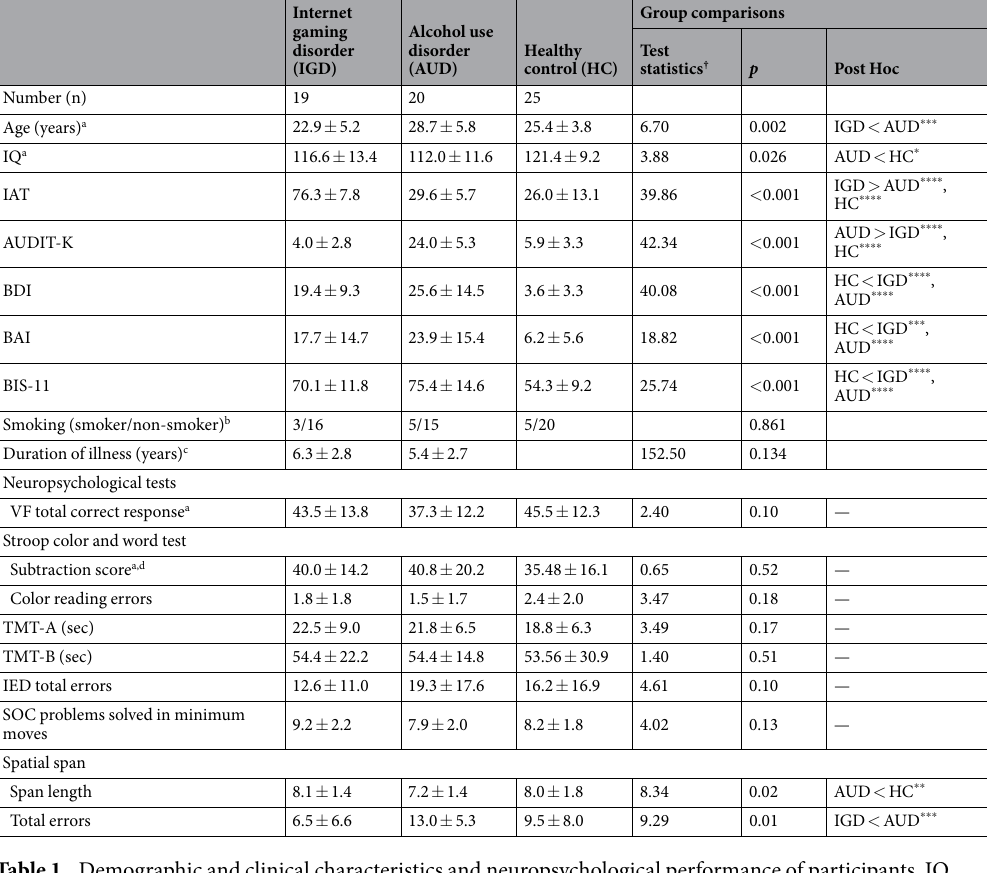
cerebellum compared with controls (minimum cluster size = 973 voxels) (Fig. 1b, Table 2). Comparisons between the IGD and the AUD groups revealed no significant differences in cortical volume. Differences in cortical thickness. the adjacent anterior midcingulate cortex (aMCC) relative to the HCs (peak MNI coordinates, x = − 10, y = 24, z = 37; cluster-wise p = 0.04) (Fig. 2). Relationship between brain cortical changes and clinical characteristics. The gray matter vol- ume in the right hippocampus of the individuals with IGD was positively correlated with their Young’s Internet Addiction Test (IAT) scores ( r = 0.63, p = 0.004) (Fig. 3a). For the AUD group, left cerebellar volume was neg- atively correlated with illness duration ( r = − 0.60, p = 0.006) (Fig. 3b), and bilateral cerebellar volume was negatively correlated with total errors on the SSP ( r = − 0.77, p < 0.001) (Fig. 3c). These correlations were not significant after corrections for multiple comparisons. Any clinical characteristics did not show correlations with cortical thickness changes. Functional connectivity pattern of the hippocampus/amygdala. The bilateral hippocampus/amyg- dala clusters of the VBM analysis was defined as seed ROI for the resting-state functional connectivity analysis, because this region also showed significant correlation with IAT, and their essential roles in the memory and learning of addiction-related cues is suggested 23, 24 . There were no brain regions showing significant differences in functional connectivity with the hippocampus/amygdala between HCs and each addiction group, AUD and IGD. However, the individuals with IGD showed significant stronger functional connectivity with the hippocampus/